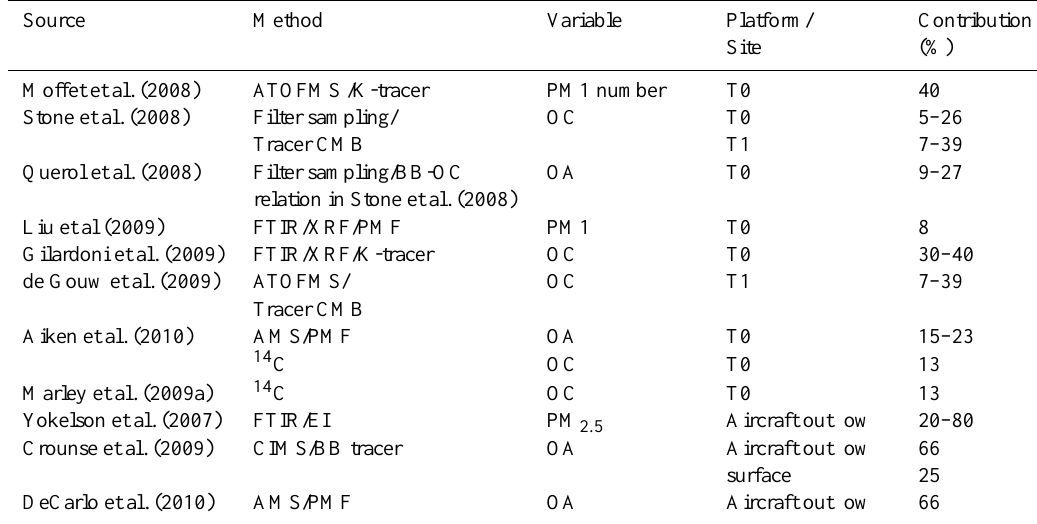
Table 1. Measurement-based estimates of BB contributions to aerosol in the MCMA and/or its